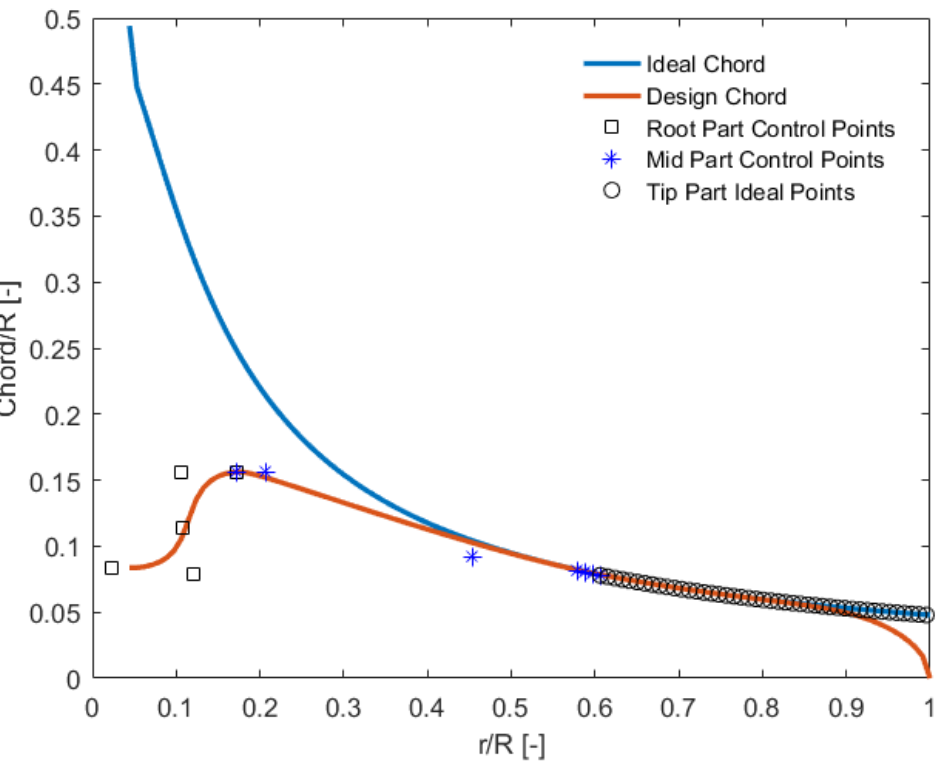
Figure 5. Modification of the ideal chord implementing a smooth curve using control points and a Bezier curve.